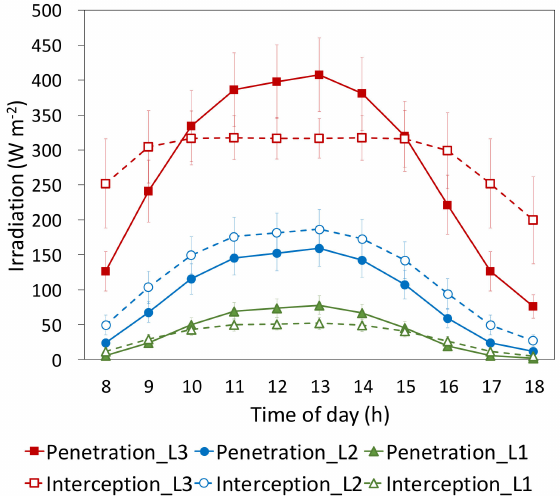
Figure 10. Irradiation calculated from Equations (21)–(30): Penetrated and intercepted irradiation through canopy including sunlit and shaded for all components of the beam, scattered diffuse, and scattered beam, where L3 is LAI3, L2 is LAI2, and L1 is